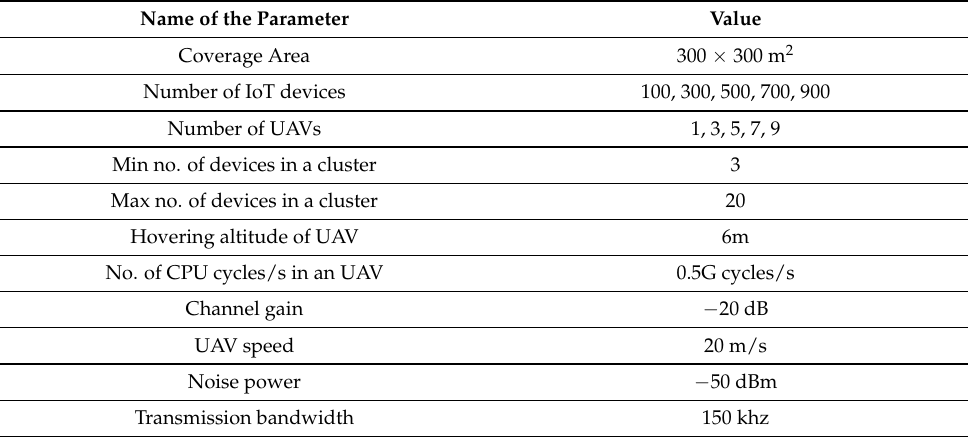
Table 3. Names and Values of Various Simulation